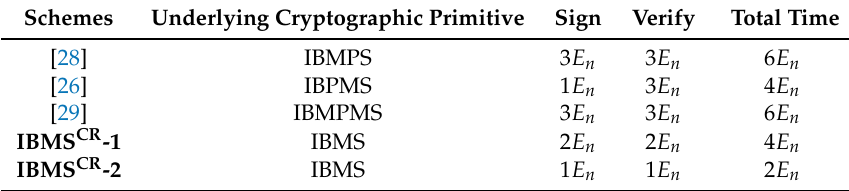
Table 3. The comparison of related work on computational performance based on the cubic residues.